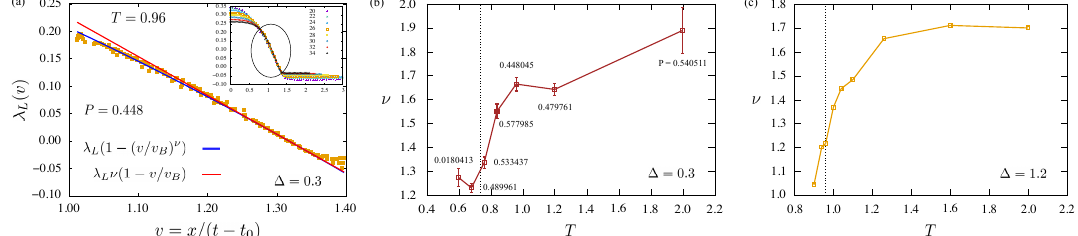
Figure 14: Velocity-dependent Lyapunov exponent: (a) Scaling collapsed of gen- eralized Lyapunov exponent (zoomed in part inside the circle shown in the inset) ) ( t > t with v = x / ( t − t ) at temperature T = 0.96 for ∆ = 0.3 (easy plane). Error 0 0 bars are smaller than the data point symbols. We fit the region near zero crossing ( v ) = λ ν ( 1 − v / v ) (red) for known λ v ∼ 1.27 − 1.33 with λ and v and ν as L B B L L ( v ) = λ ( 1 − ( v / v ) ν ) for same values of fitting parameter. Non-linear function λ L B L the parameters is shown in blue. Goodness-of-fit indicator P -value is indicated. (b) Temperature dependence of ν extracted in the way mentioned in (a) for various tem- perature across the KT transition. P -values corresponding to each of the points are mentioned. (c) ν as a function of temperature for the easy-axis case across the Ising